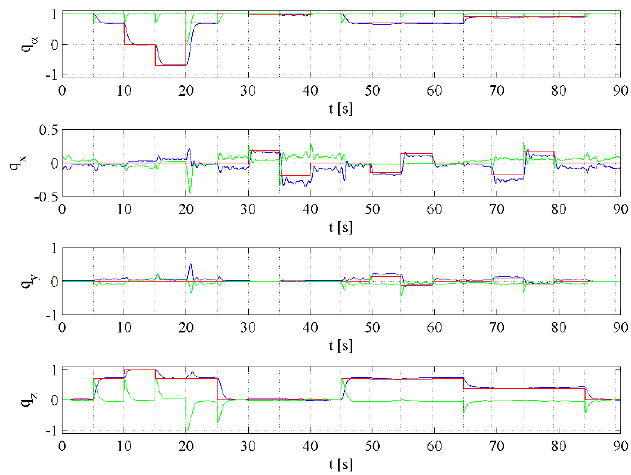
Figure 17. Performance of the sequence using backstepping controller expressed by various quaternions, such as actual quaternion (blue line), quaternion error (green line) and desired quaternion (red and line).